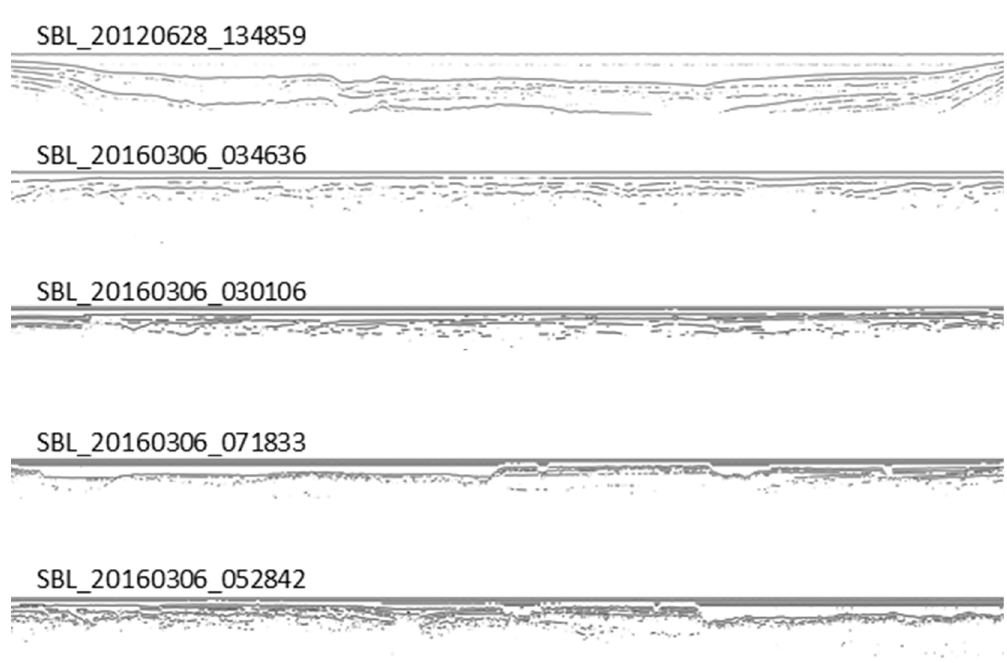
Figure 13. The horizons extracted by the automatic method.